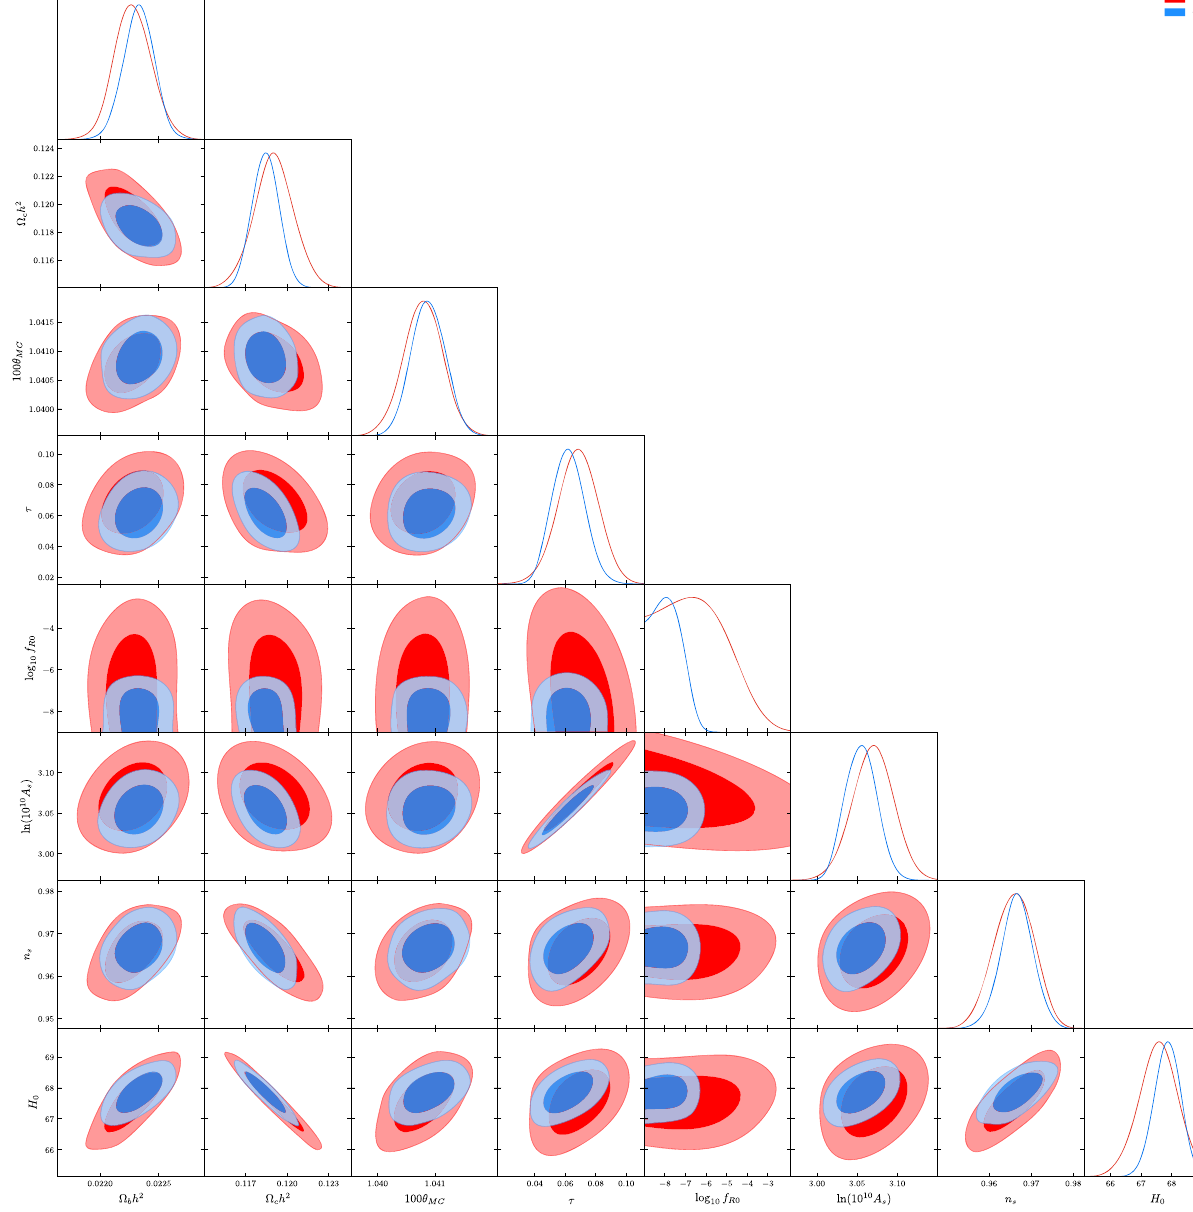
Fig. 6 ThemarginalizedconstraintsontheHS f ( R ) modelwith n = 1areshown byusingthe“C”(red)and“CBSHR”(blue)datasets,respectively